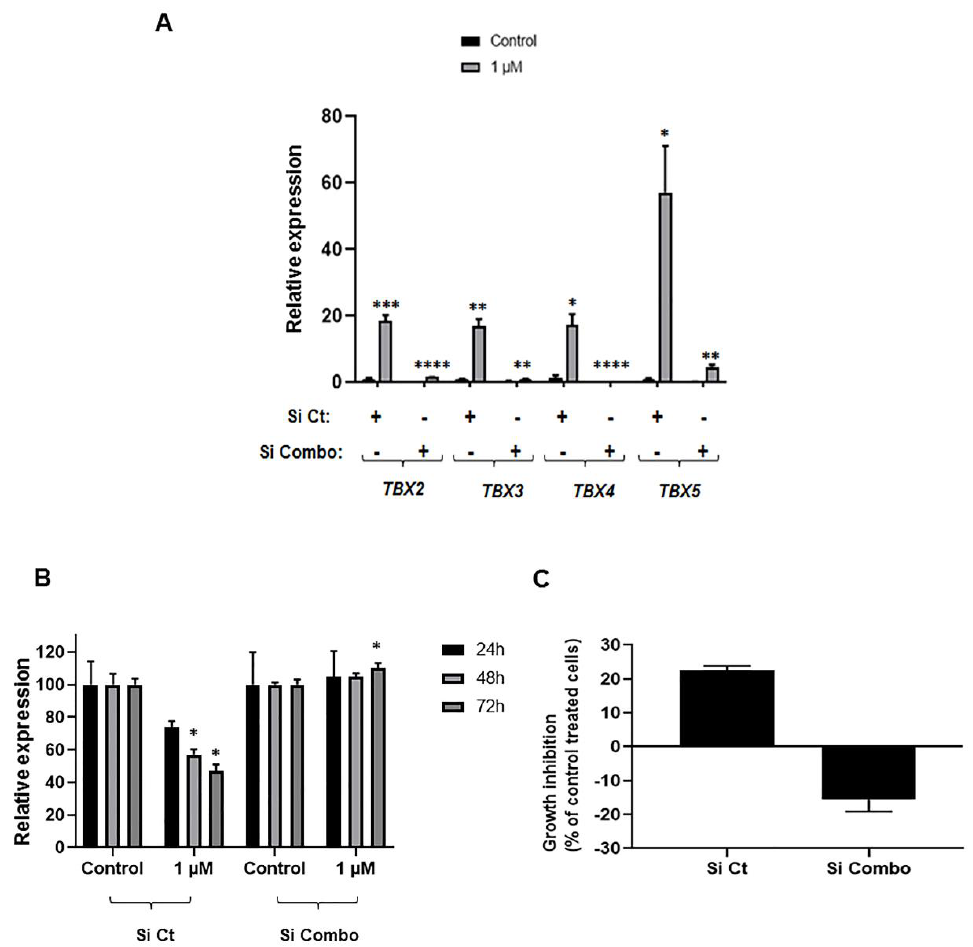
Figure 6. Impact of simultaneous knockdown of all four members of TBX2 subfamily on anti-growth effects of Aza in H1299 cells. ( A ) H1299 cells were transfected with control (4× scrambled) siRNAs and siRNAs targeting all four members of the TBX2 subfamily simultaneously (combination of four target-specific siRNAs) using Lipofectamine RNAiMAX as described in section 4. The day following transfection, cells were re-seeded in six cm dishes. The next day cells were incubated overnight with reduced serum (1% FBS) medium prior to treatment with either DMSO control or 1 µM Aza for 72 h. Total RNA was extracted and RNA expression levels of TBX2, TBX3, TBX4 and TBX5 were analyzed using the 2 −∆∆ C t calculation method by normalization to GAPDH . H1299 cells were transfected in the same manner described above, except they were re-seeded the following day in 96-well plates for MTT assays ( B ) and trypan blue exclusion analysis ( C ). Cell numbers (% of control DMSO treatment) were determined using MTT assays ( B ) and percentages of cell growth inhibition in Aza-treated cells were obtained using the trypan blue exclusion method ( C ). Growth inhibition following the trypan blue exclusion analysis was calculated using the following formula: (100 − ( treated / non-treated) × 100) and is depicted for the Aza-treated cells. Data depicted represent mean ± SD for MTT assays and mean ± SEM of triplicates for trypan blue exclusion analysis (* p < 0.05). 3. Discussion In this study, we interrogated the role of epigenetic silencing in suppressed expression of the TBX2 subfamily of transcription factors in NSCLC. By in silico analysis of a cohort of NSCLCs and normal lung tissues, we first found that all four members of the TBX2 subfamily were, overall, hypermethylated, at both promoter regions and CpG islands, in clinical NSCLC samples compared to normal lung. Methylation β -values for the genes, with exception of TBX2 , were overall significantly inversely correlated with corresponding mRNA expression levels. Also, we found no statistically